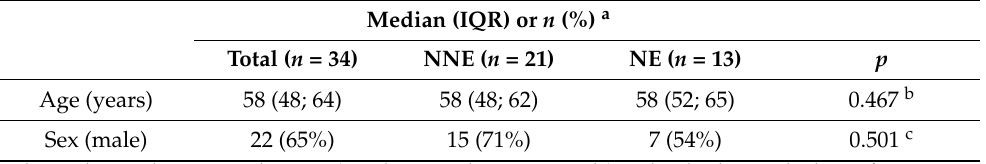
Table 1. Basic characteristics of the patient groups (all patients, patients in whom no nail extrac- tion was performed—NNE, and patients in whom nail was extracted—NE); p -value indicates the significance of differences between the NNE and NE